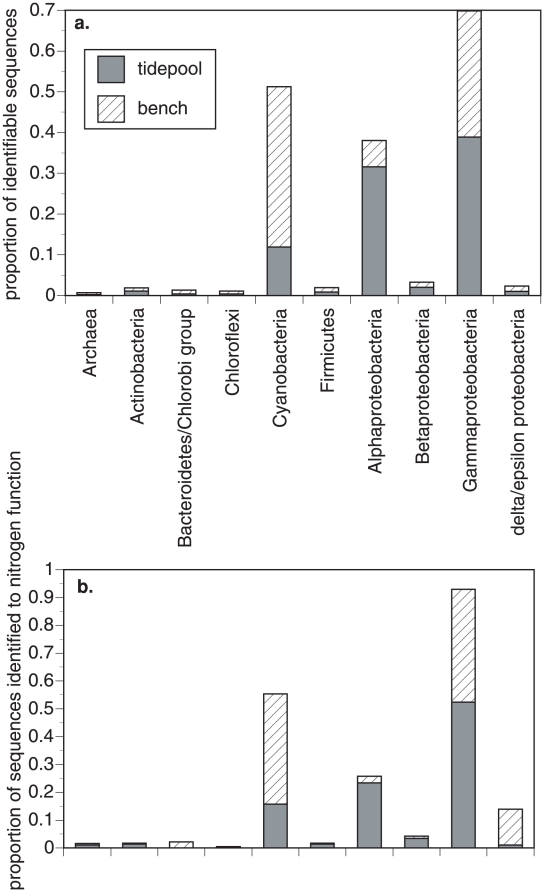
Taxonomic composition of surface-associated microbes of tidepool and emergent (bench) mussels.a. The relative representation of microbial phylogenetic groups in both the tidepool and emergent (bench) mussel samples based on shotgun pyrosequencing. Proportional representation is based on 157,599 total contiguous sequences for the tidepool mussels and 141,293 for the bench mussels. In b., the taxonomic composition as related to enzymes for nitrogen metabolism in Fig. 3.